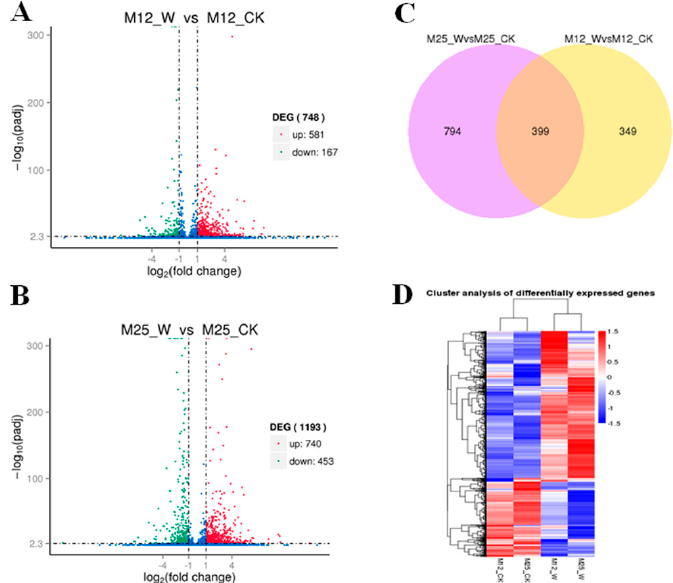
Figure 4. Volcano plots of differentially abundant transcripts in waterlogging-tolerant ( A , M12) and waterlogging-sensitive ( B , M25) plants after RNA-seq analysis. The x -axis represents the natural logarithm of fold change (Fc) and the y -axis represents log10 of the p -value of each transcript; ( C ) Differentially abundant transcripts showed in Venn diagram form; ( D ) hierarchical clustering analysis of waterlogging-induced changes in transcripts in leaves of alfalfa (M12CK indicates M12 under control condition; M12W indicates M12 under waterlogged condition; M25CK indicates M25 under control condition; M25W indicates M25 under waterlogged condition).